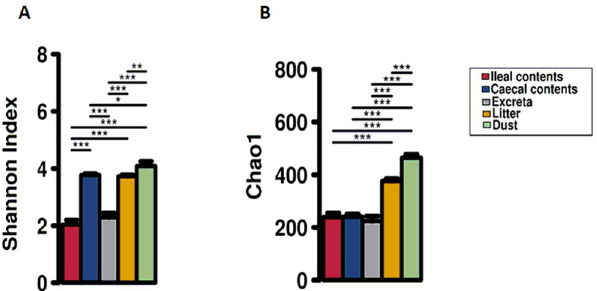
Fig 1. Alpha diversity assessed by Shannon diversity (A) and Chao1 richness (B). � Denotes significant difference at the P < 0.05 level, �� denotes significant difference at P < 0.01 level, ��� denotes significant difference at the P < 0.001 level between sample types connected by a line.